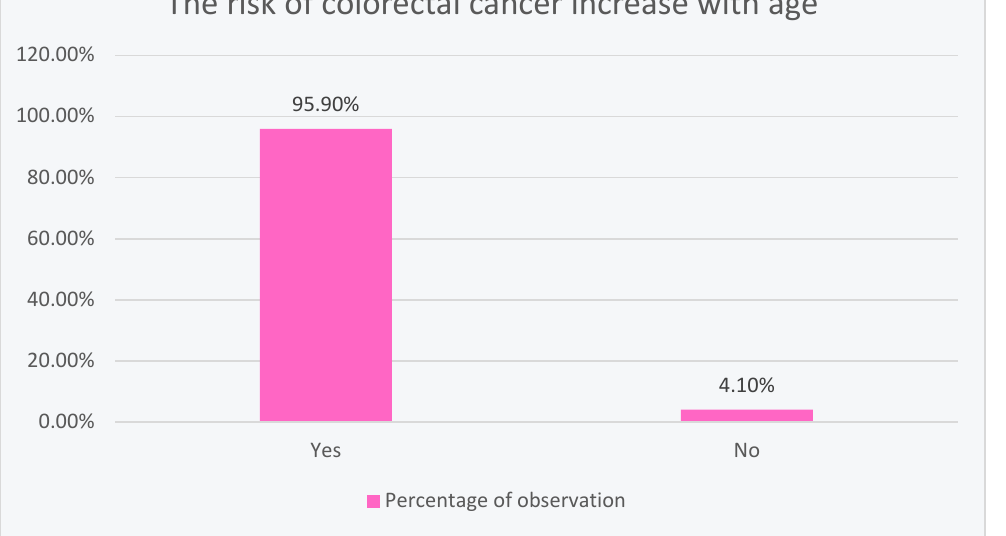
Figure 3. Colorectal cancer and its correlation with patient age according to respondents’ knowledge.